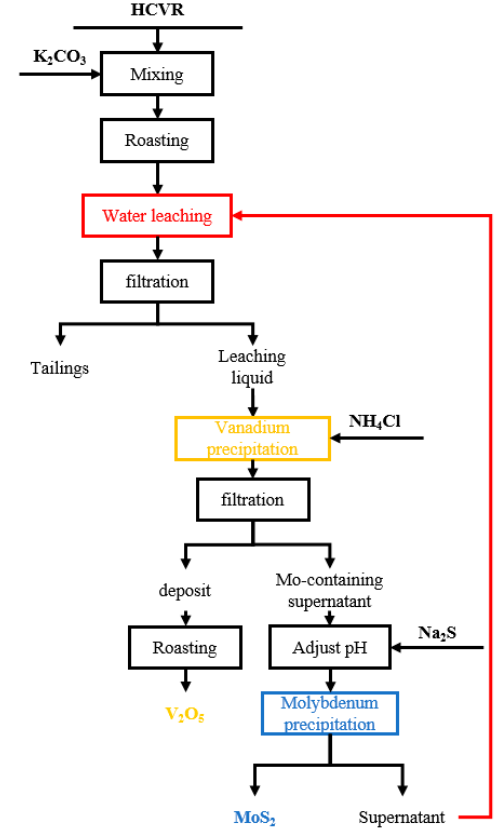
Figure 2. Flow chart of the comprehensive utilization of HCVR.